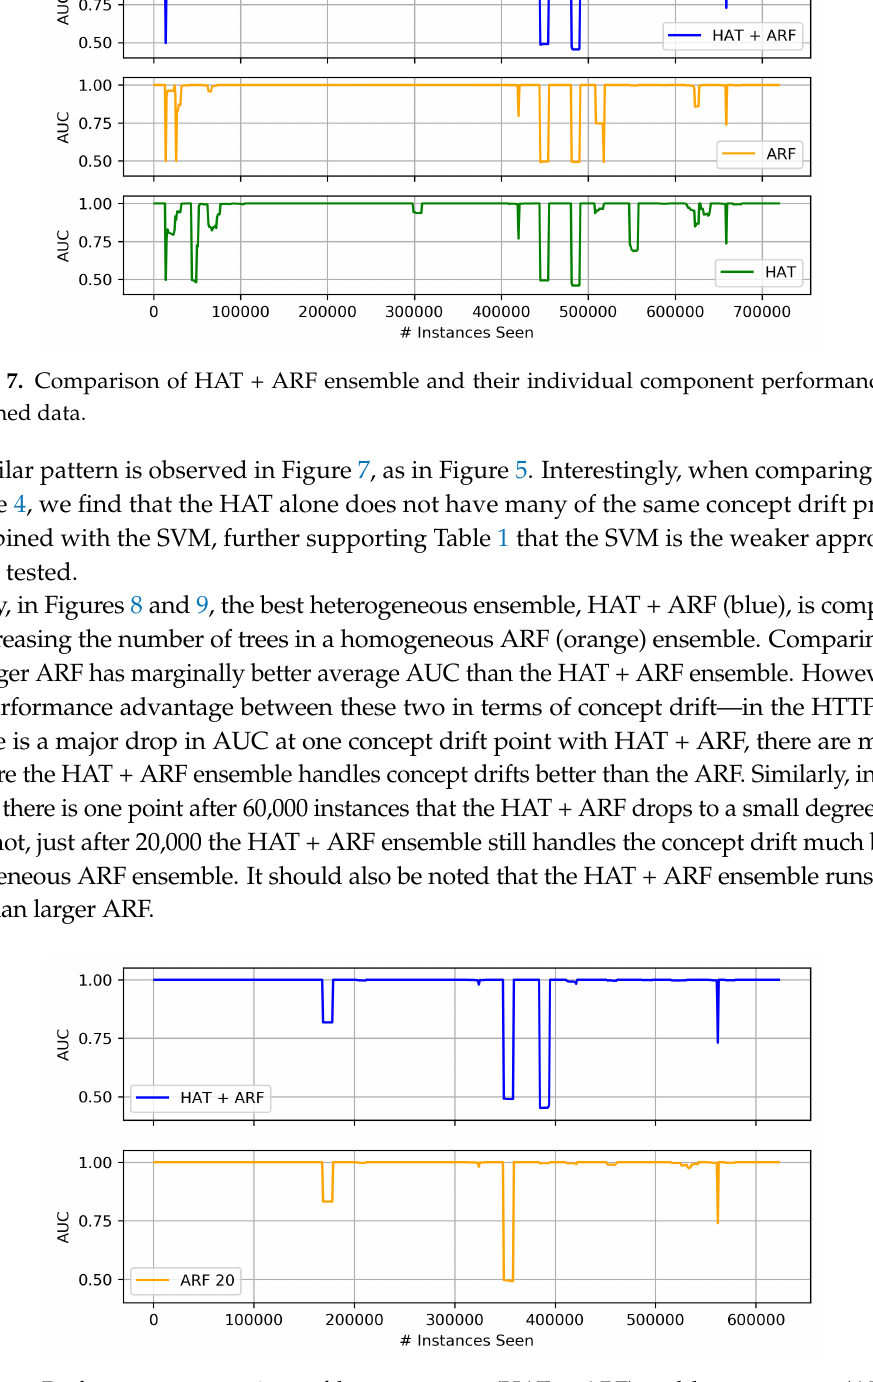
Figure 8. Performance comparison of heterogeneous (HAT + ARF) and homogeneous (ARF-20) ensembles on